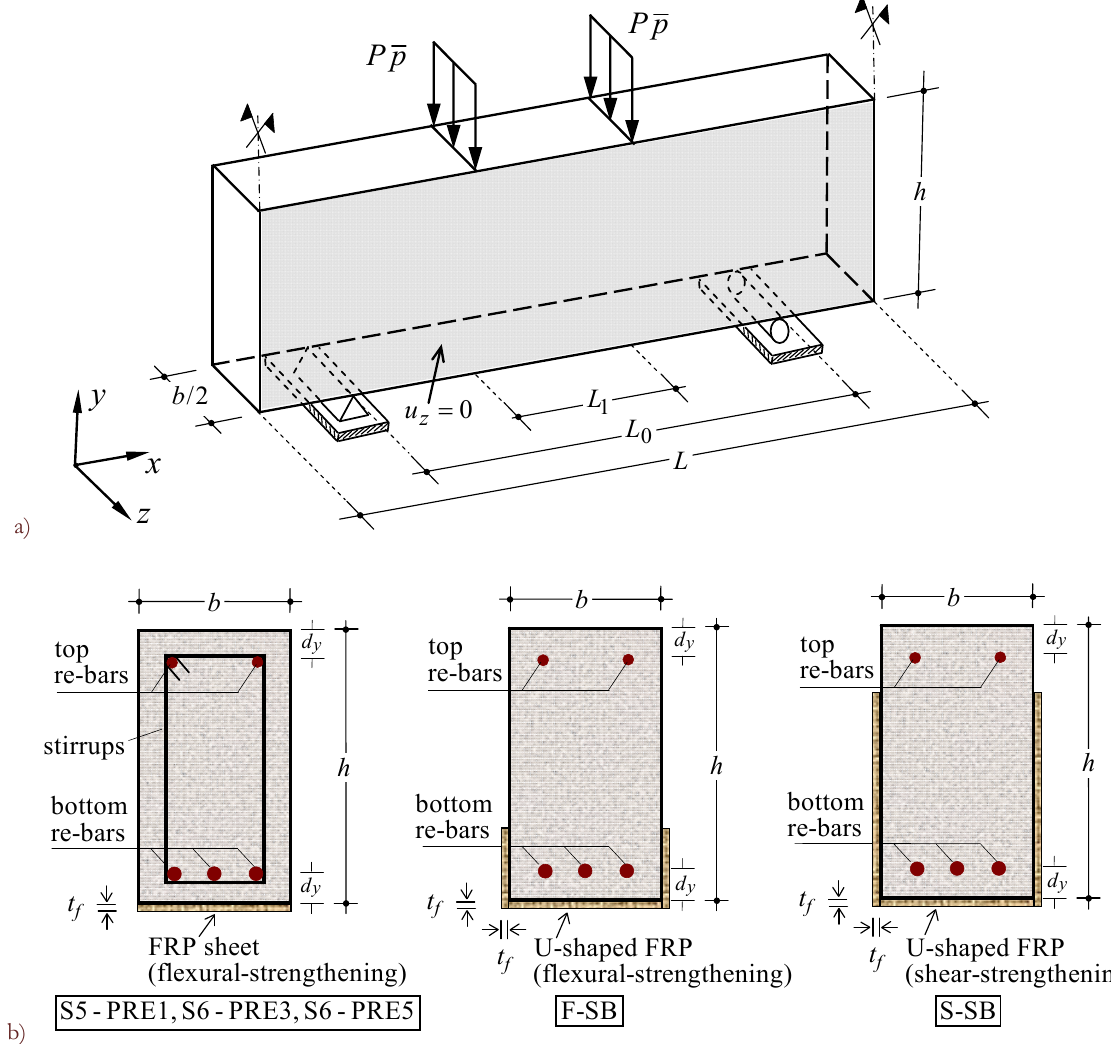
Figure 3: Mechanical model of the analysed specimens: a) geometry, loading and boundary conditions; b) cross-section details with FRP strengthening